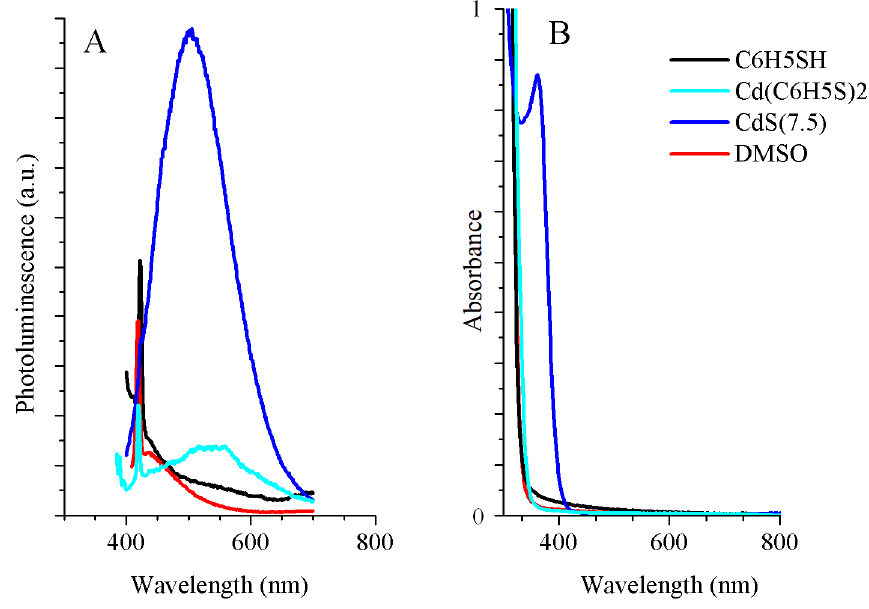
Figure 2. Photoluminescence spectra ( A ) and pristine optical absorption spectra ( B ) for thiophenol (black) and cadmium thiolate (cyan) CdS nanoparticles synthesized with 7.5 milliliters of sulphur solution per gram of cadmium thiolate in toluene (blue) and DMSO (red).